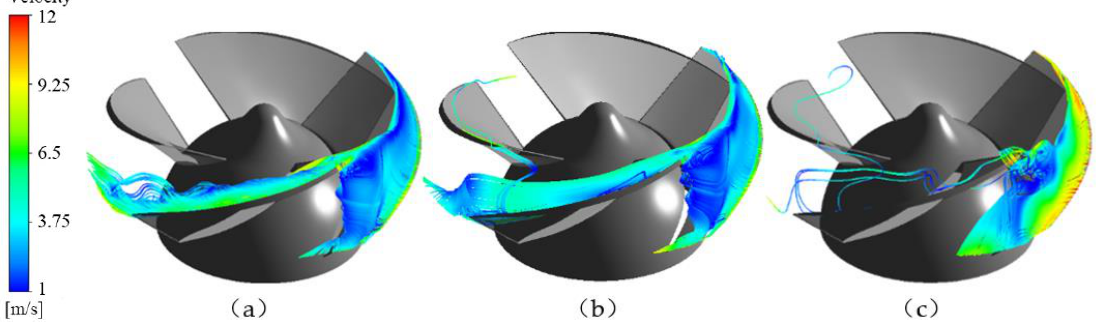
Figure 19. Form change of leakage flow ( δ = 0.5 mm).